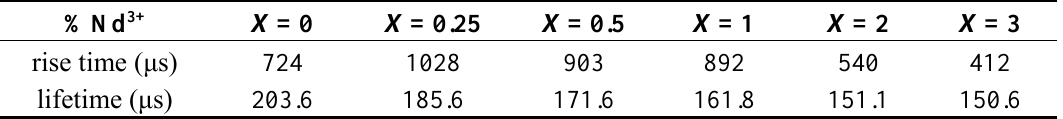
Table 1. Rise times and lifetimes for individual 540-nm upconversion emission of NaYF 4 : Yb/Er/Nd (20/2/ X mol%)